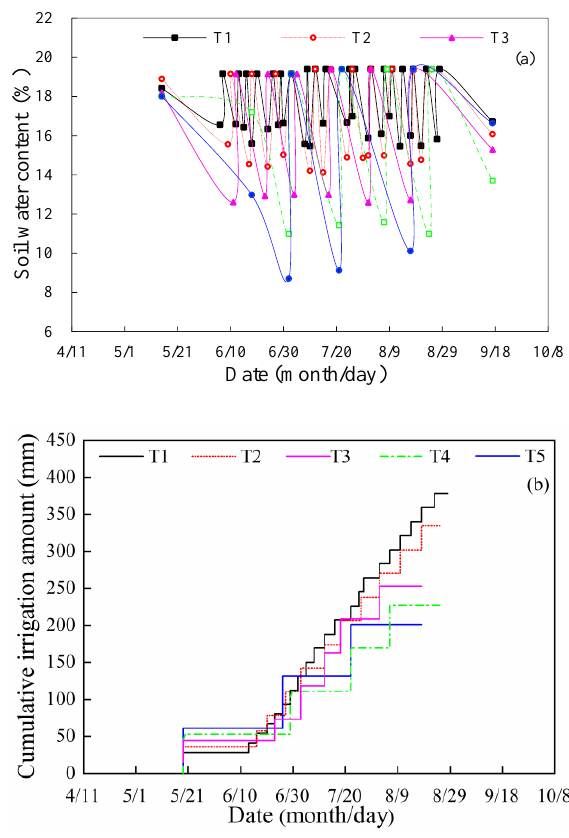
Figure 4. Variation in soil water content and accumulative irrigation amount for treatments. ( a ) Variation in soil water content; ( b ) Accumulative irrigation amount. Table 2. The daily water consumption intensity and water consumption percentage of